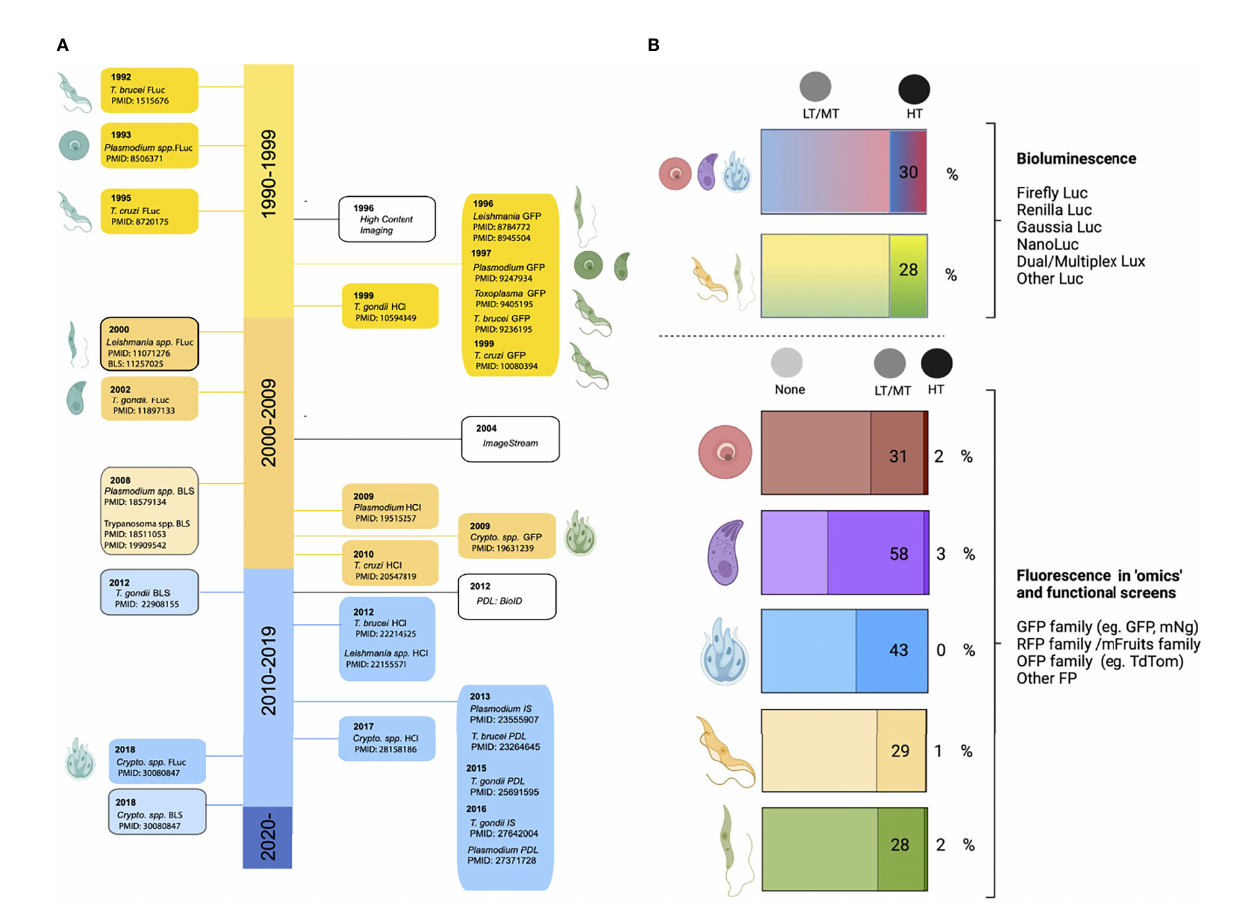
FIGURE 9 | Microscopy usage in parasitology. (A) Timeline of key developments allowing high-throughput bioluminescent and fl uorescent studies. The left side of the timeline shows the fi rst transgenic bioluminescent lines created for each parasite ( Plasmodium spp. , Toxoplasma gondii, Cryptosporidium spp. , Trypanosoma spp., and Leishmania spp.), as well as the fi rst luminescence-based high-throughput screen (BLS) performed for each parasite. The right side shows the fi rst generation of fl uorescent reporter lines for each parasite, and the fi rst use of high-throughput fl uorescence imaging, including the use of high content imaging (HCI), ImageStream, and proximity- dependent labelling (PDL). (B) Top section shows studies using bioluminescent reporter parasite lines, specifying the percentage used in high-throughput screens (HTS) for Apicomplexans ( Plasmodium spp. , Toxoplasma gondii and Cryptosporidium spp., Kinetoplastids (Leishmania spp., and Trypanosoma spp.). Bottom section shows the proportion of ‘ omics ’ and high-throughput screens using no imaging, low/medium throughput imaging (LT/MT), or high throughput imaging (HT). A PubMed search was performed for each genus, for all ‘ omics ’ methods, and each was explored to determine usage and throughput of microscopy. Figure created with